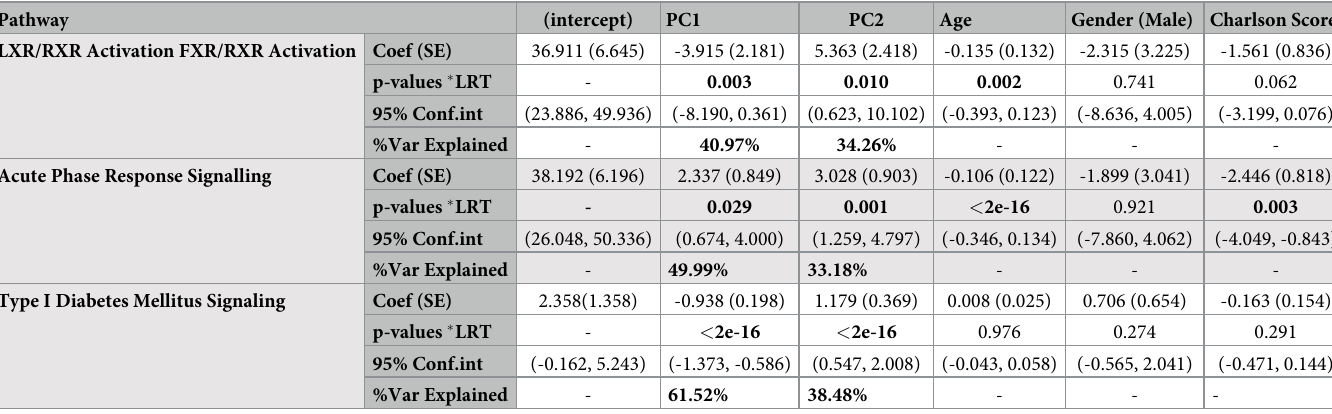
Table 4. Regression models for proteins associated with COVID-19 status.